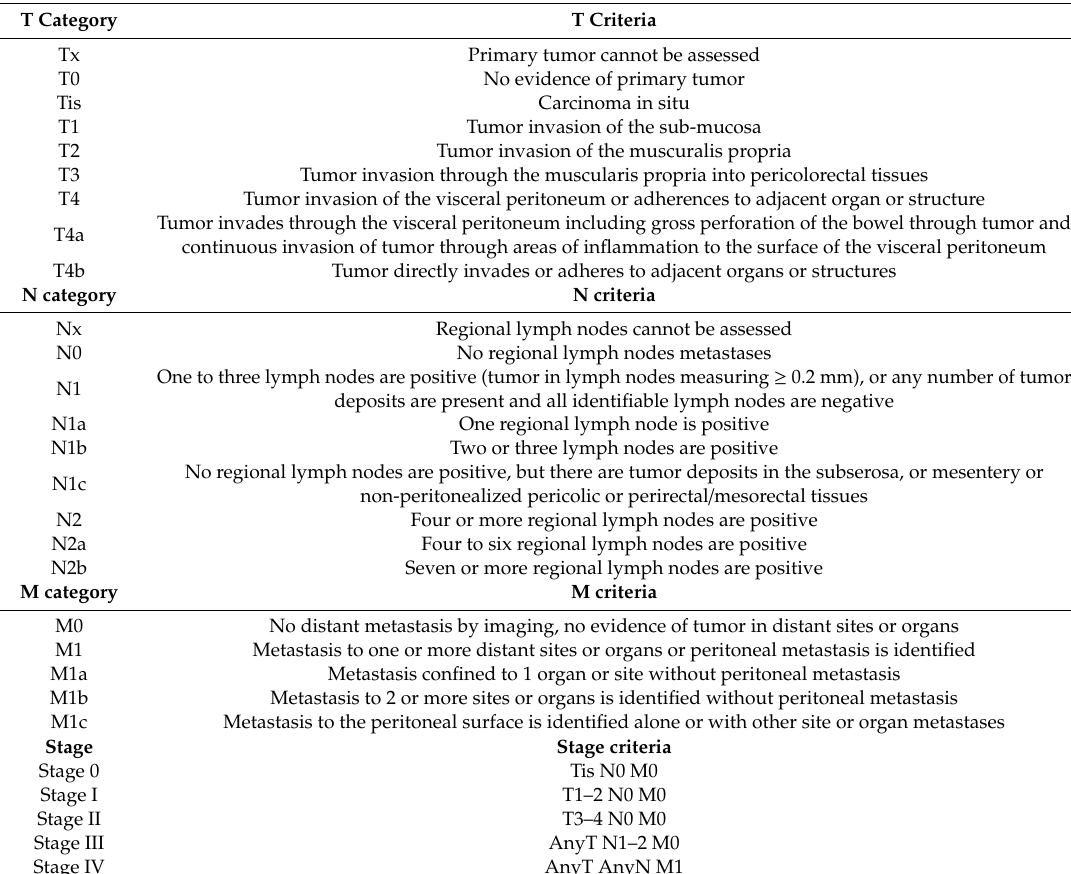
Table 1. American Joint Committee on Cancer (AJCC) TNM (Tumor, Nodes, Metastasis) system and staging 8th edition of colorectal